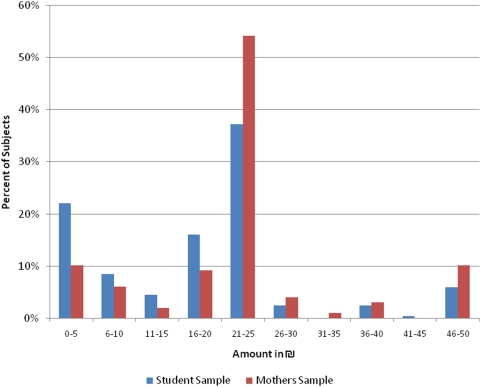
Distribution of Dictator allocations for student and mother samples.Allocation sums by participants grouped in  5 increments ( 5≈$1.17). For both samples, the modal value of  25 was used as the cutoff point to divide participants into low and high allocators.